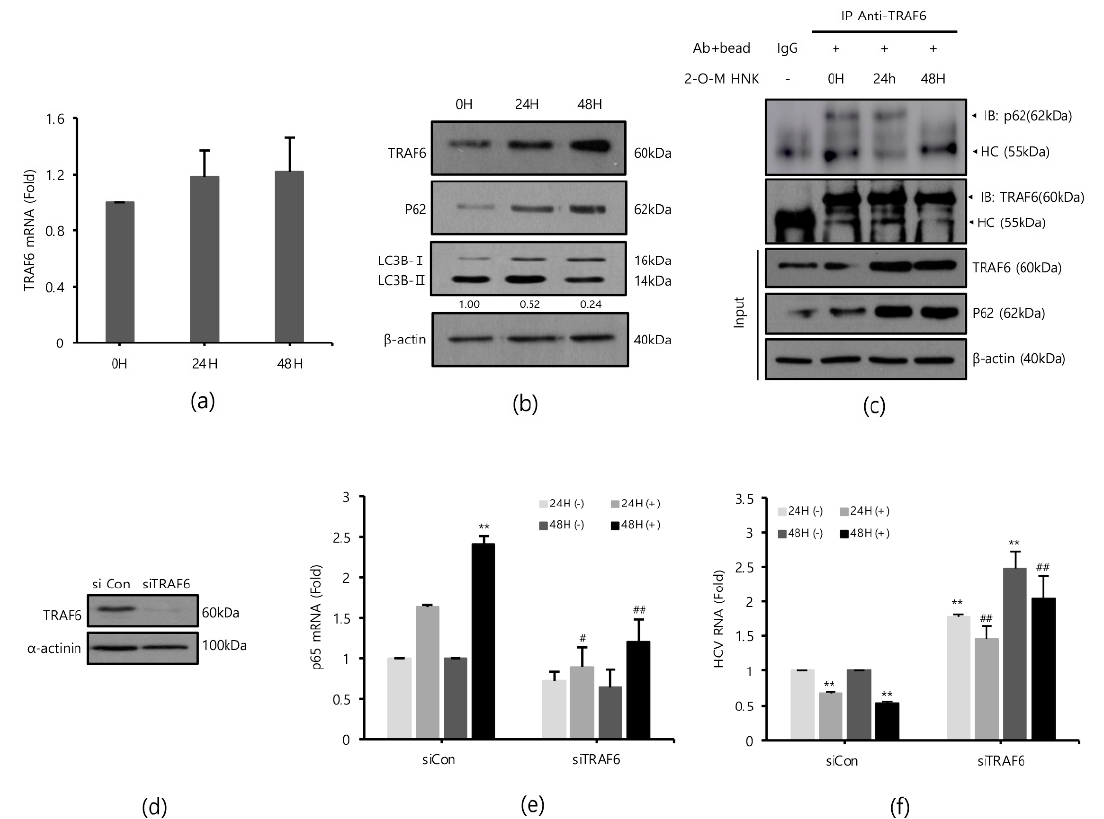
Figure 4. 2-O-methylhonokiol enhances TFAF6-mediated NF-kB activation. After treatment with 50 µ M 2-O-methylhonokiol for 24 or 48 h, ( a ) TRAF6 mRNA levels were analyzed by qRT-PCR, and ( b ) the protein levels of TRAF6, p62, and LC3B were analyzed by Western blotting. ( c ) Immunoprecipitation was performed with Huh7.5-Con1 cells with or without 50 µ M 2-O-methylhonokiol for 24 or 48 h using antibodies against TRAF6, and precipitated protein complexes were probed with anti-p62 antibodies. The total cell lysates were also used for immunoblotting to serve as the input control. HC, antibody heavy chain; 2-O-M HNK, 2-O-methylhonokiol. ( d ) Expression of TRAF6 protein in control (si-Con) and TRAF6-interfered (si-TRAF6) Huh7.5/Con1 cells is shown. After transfection with si-Con or si-TRAF6 for 48 h, Huh7.5/Con cells were treated with or without 50 µ M 2-O-methylhonokiol for 24 or 48 h. ( e ) The mRNA level of p65 and ( f ) the HCV RNA level were then analyzed by qRT-PCR. The mRNA level of p65 and HCV RNA level were normalized against β -actin RNA. In each experiment, ‘0H’ means a DMSO control. The values are shown as the mean ± SD of five independent experiments. ** p < 0.01 versus untreated control or versus the untreated siCon-transfected control; # p < 0.05, ## p < 0.01 versus the 2-O-methylhonokiol-treated, siCon- transfected control or versus CQ or 2-O-M HNK; one-way ANOVA with Tukey’s multiple comparisons test.